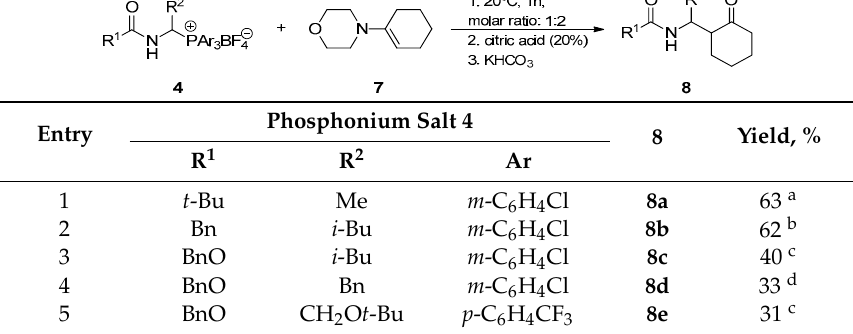
Table 2. Conditions and yields for α -amidoalkylation of 1-morpholinocyclohexene by 1-( N -acylamino)alkyltriarylphosphonium salts 4 .